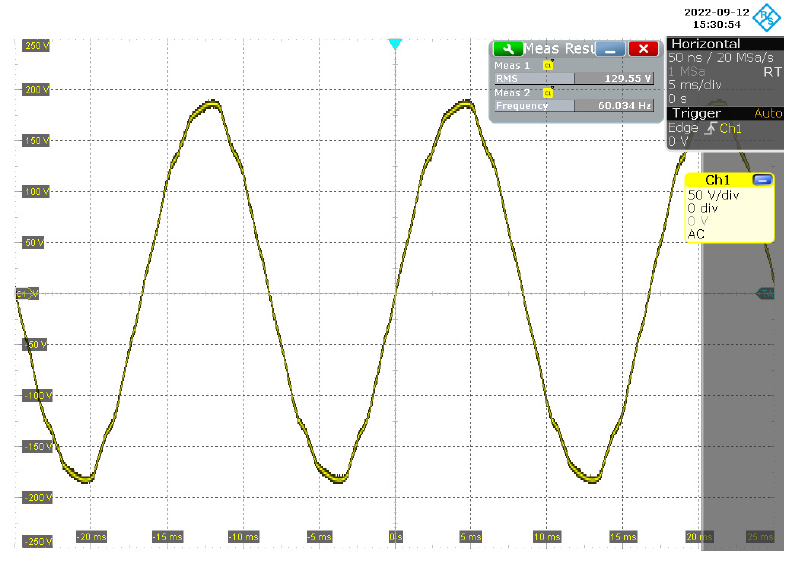
Figure 11. The waveform of the voltage signal at the input of the NB–PLC notch coupling